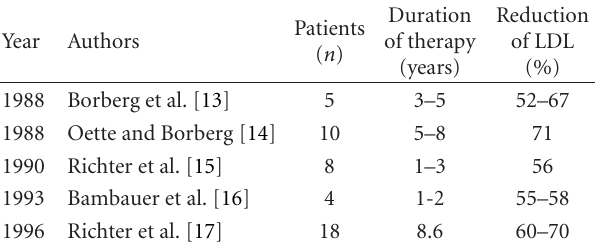
Table 4: Immunoadsorption (Therasorb, Miltenyi, Germany) in hypercholesterolemia (selection of